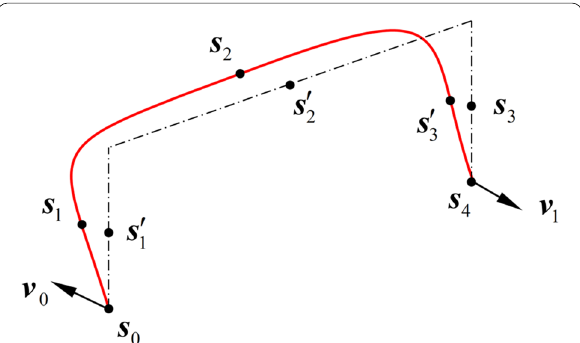
Figure 1 Space equal-height pick-and-place